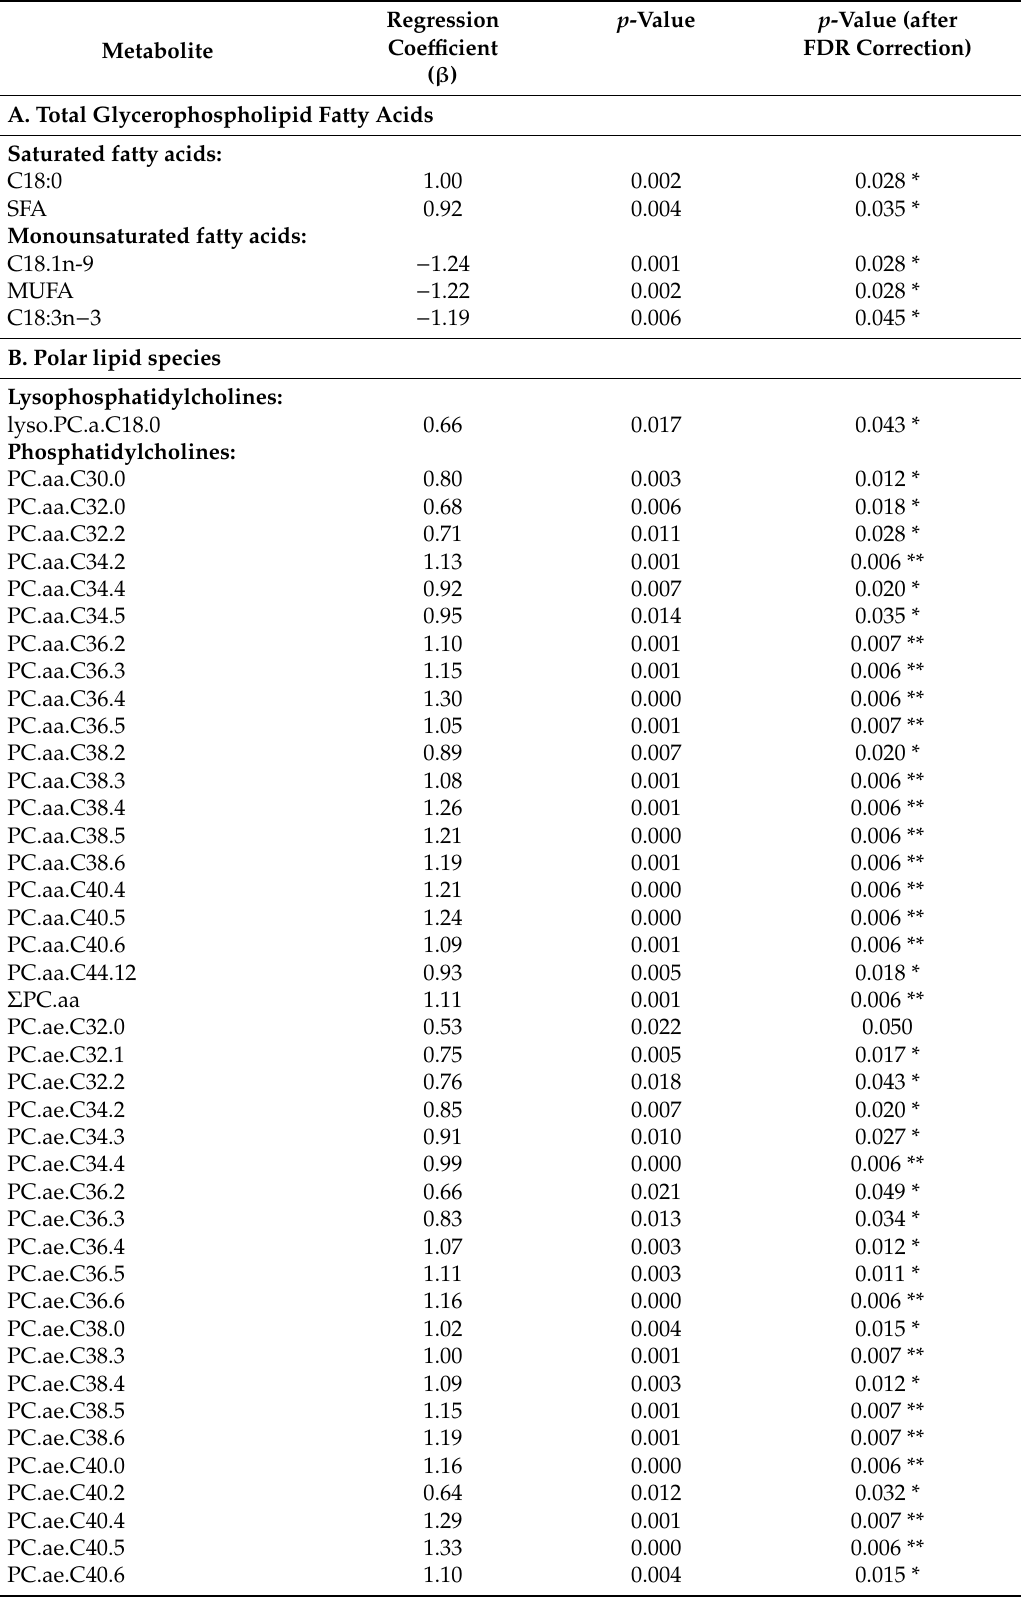
Table 6. Significant results from the linear models for the change in ( A ) total glycerophospholipid fatty acids and ( B ) phospholipid species with child’s breastfeeding status at baseline in severe malnourished children treated with